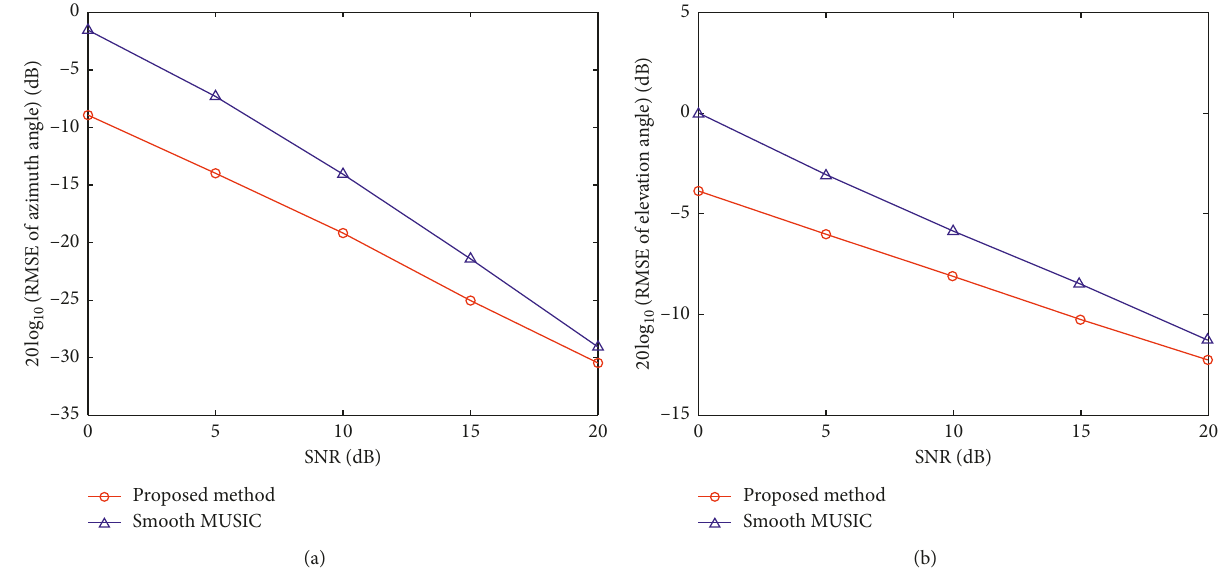
Figure 6: RMSEs versus SNR. (a) Azimuth angle. (b) Elevation